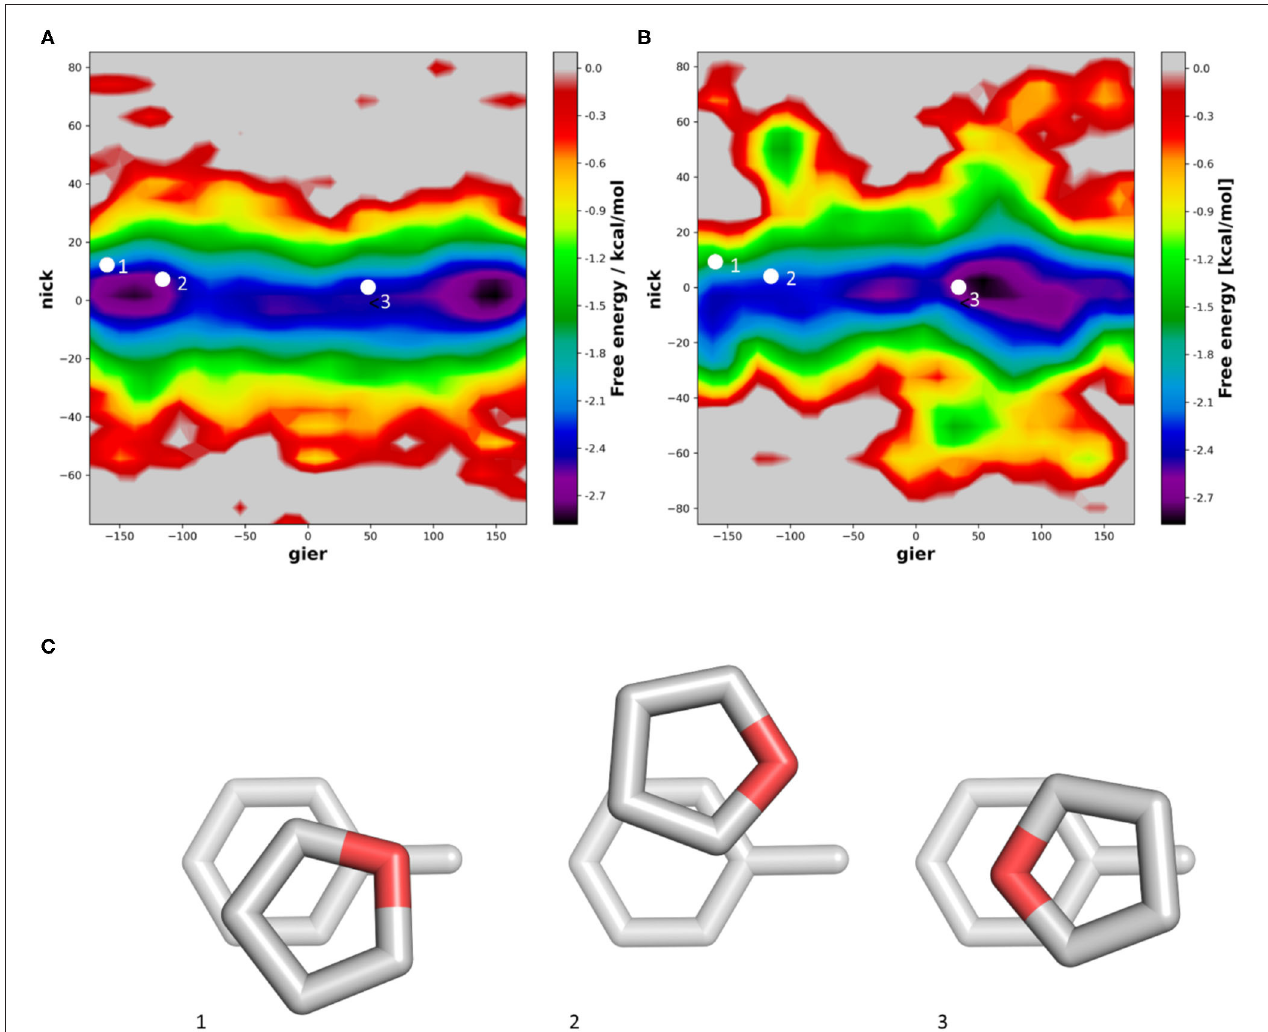
FIGURE 6 | Distribution of the nick and gier angles of furan during molecular dynamics simulations in complex with toluene in vacuum (A) and in water (B) using 2D histograms. We mapped the orientations of published optimized geometries of furan stacking with toluene (C) into the density surface.